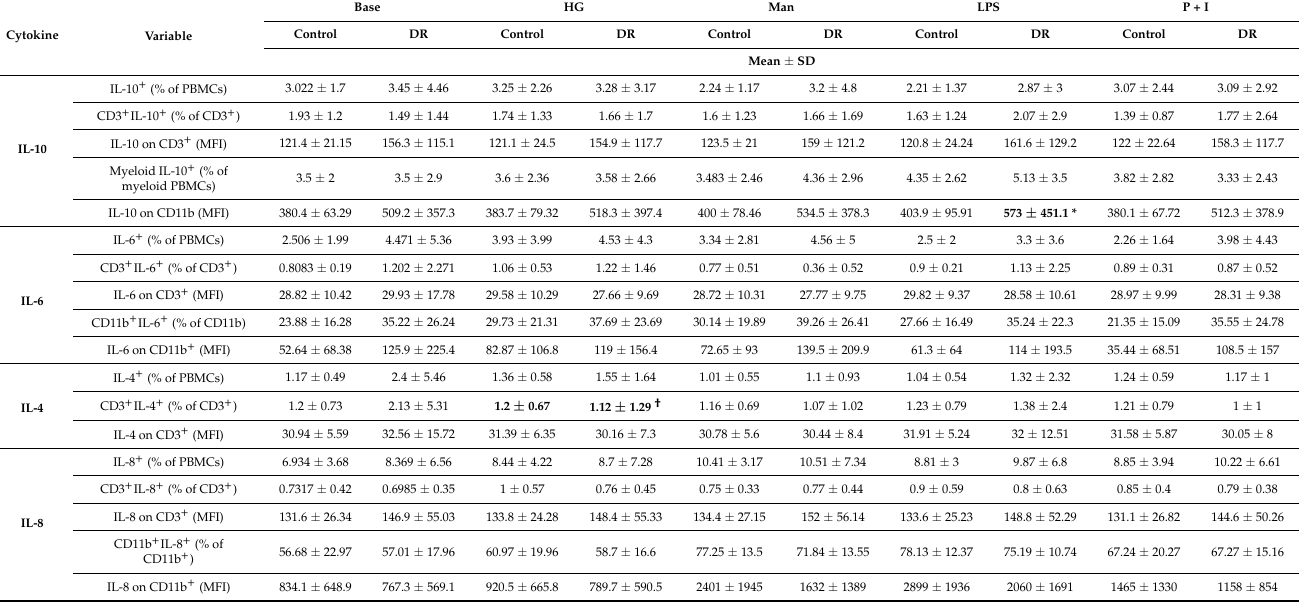
Bold mean ± SD show statistically significant differences on comparison of DR patients and healthy controls. * p < 0.05 in Independent Samples t -test while † p < 0.05 in Mann Whitney test. Base (Baseline); DR, diabetic retinopathy; HG, D-glucose (25 mM); LPS ( E. coli lipopolysaccharide); Man, D-mannitol (25 mM); MFI, mean fluorescent intensity; P + I; phorbol 12-myristate 13-acetate and ionomycin; SD, standard deviation; n = 14 for controls and 39 for